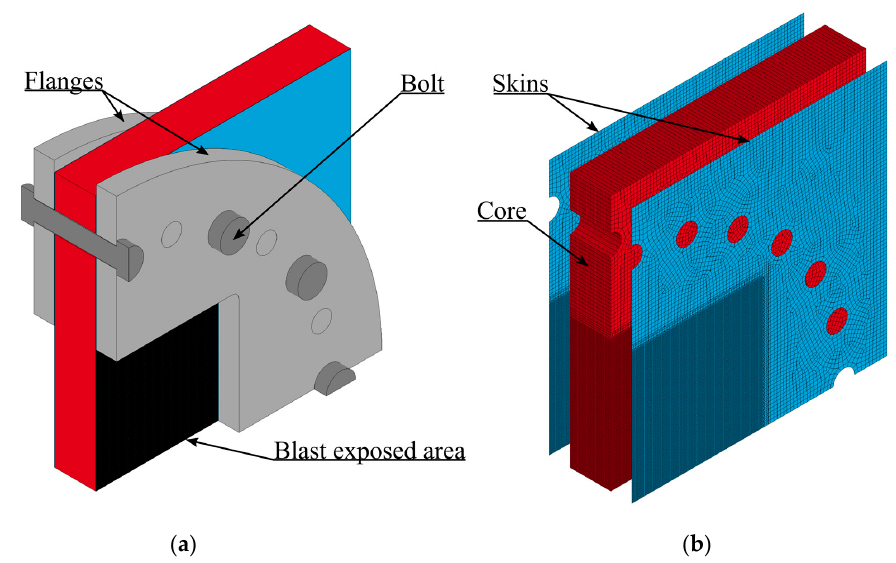
Figure 15. Illustrations of the numerical model: ( a ) Complete assembly and ( b ) sandwich specimen. Note that the mesh for flanges and bolts is omitted for clarity.